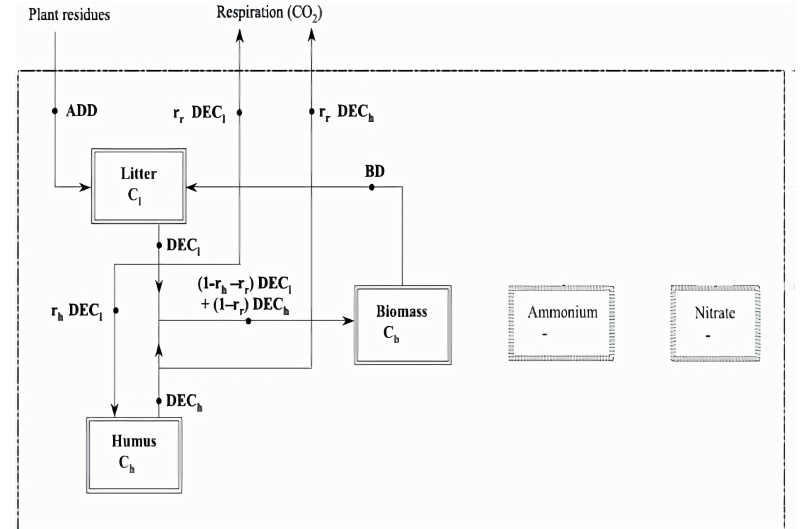
Figure 2. Various Carbon pools of the lean soil nutrient dynamics model [10].